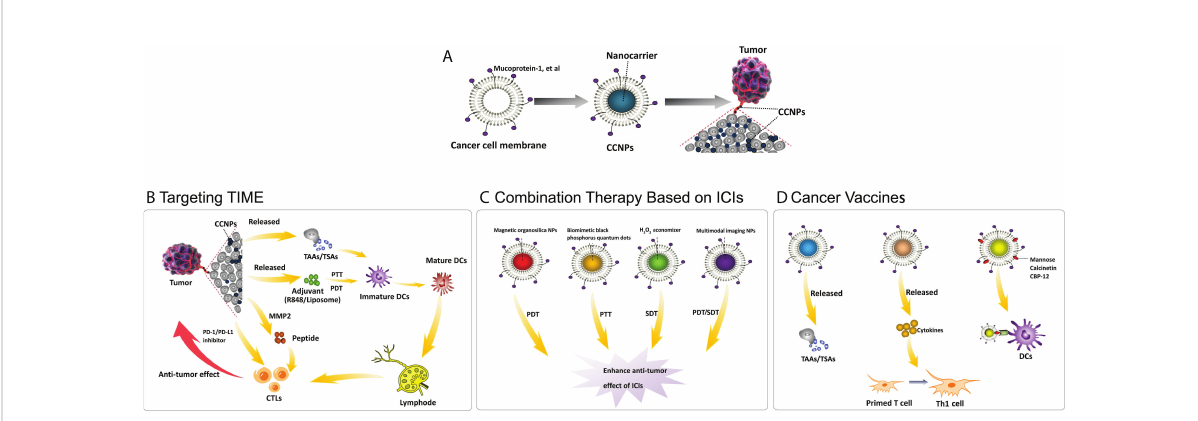
FIGURE 1 Application of cancer cell membrane-wrapped nanoparticles for cancer immunotherapy. (A) The structure of CCNPs; (B) Mechanism of CCNPs targeting on TME: CCNPs directly carry TSAs from cancer cell membranes or by different stimuli, such as PTT, then release TAAs. The released TSAs/TAAs, together with the immune adjuvant (R837/Liposome), drive the maturation of DCs. The CCNPs also used the tumor-speci fi c enzyme metallomatrix protease 2 (MMP2) to dramatically extend the half-life of the peptides, e.g. PD-L1 inhibitory peptides, or combined with PD-1/PD- L1 inhibitors to further enhance the anti-tumor effect. The above processes promote the in fi ltration of CTLs for treating distant metastasis. (C) Combination therapy based on ICIs: A combination therapeutic strategy that includes PDT, PTT and SDT, particularly robust anti-cancer agents loaded on CCNPs, results in enhanced anti-tumor effect of PD-1/PD-L1 inhibitors. (D) Cancer vaccines: As tumor vaccines, CCNPs can directly release TSAs/TAAs, release cytokines to promote the transformation of functional immune cells or are added special molecules on the cancer cell membrane to increase the antigen presentation to DCs, thus further enhancing the anti-tumor immune effect. Abbreviations: CCNPs = cancer cell membrane-wrapped nanoparticles, TIME = tumor immune microenvironment, TAAs = tumor-associated antigens, TSAs = tumor- speci fi c antigens, PTT = photothermal therapy, PDT = photodynamic therapy, MMP2 = metallomatrix protease 2, PD-L1/PD-1 = programmed death-ligand 1/programmed death-1, CTLs = cytotoxic T lymphocytes, DCs = dendritic cells, ICIs = immune checkpoint inhibitors, NPs = nanoparticles, SDT = sonodynamic therapy, PDT = photodynamic therapy, Th1 cell = T helper 1 cell, CBP-12 = 12-mer Clec9a binding